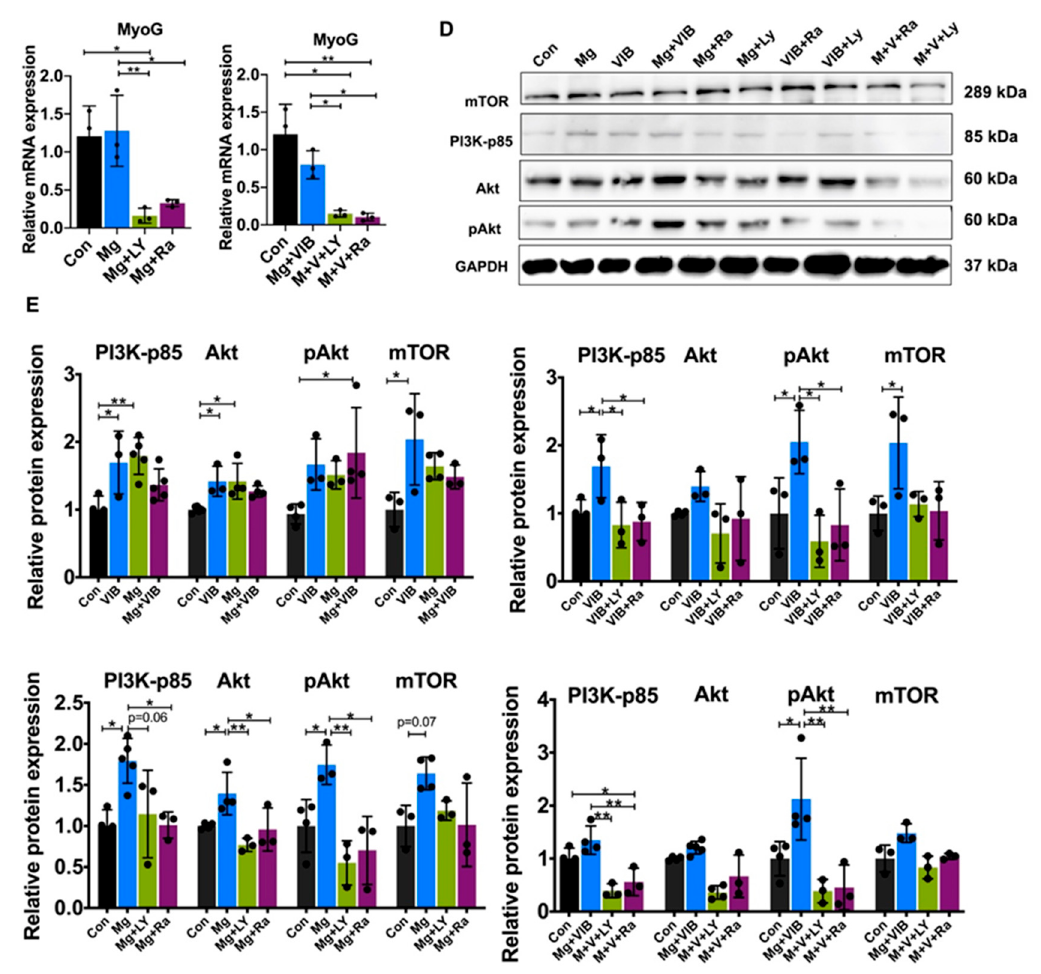
Figure 7. Treatment effects on myogenesis, atrogenes mRNA expression and PI3K/Akt/mTOR pathway with inhibitors in the C2C12 myoblast cell line. ( A ) Heatmap of MRF and atrogenes showed that ( B ) both the VIB and Mg groups could significantly increase the relative expression level of Myf5 mRNA compared with the Con group. The VIB and Mg + VIB groups showed a similar significantly increasing effect on Myf6 mRNA expression compared with the Con group. ( C ) Inhibitor groups had significantly decreased Myf5 and MyoG expression. ( D , E ) Western blots of protein expressions of mTOR, PI3K-p85, Akt, pAkt and GAPDH in different treatment groups in vitro. * p < 0.05, ** p < 0.01 and *** p < 0.001, n = 3–5.